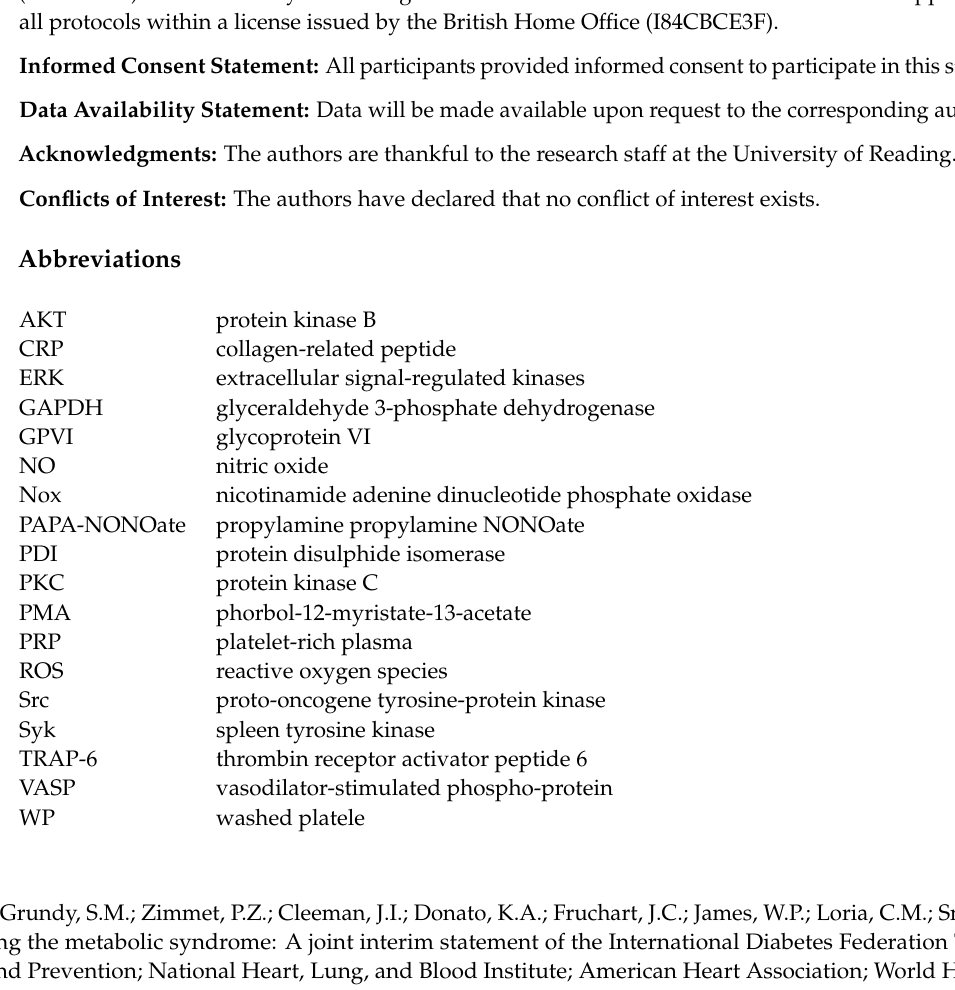
Figure S5: PDI and Nox-1 co-inhibition decreases phosphorylation of p47phox, Figure S6: Summary of molecular processes regulated by PDI and Nox-1 in collagen-mediated signal, Figure S7: Platelet PDI and Nox-1 are not increased in hyperglycaemia, Table S1: Full blood count of WT and Nox-1 − / − mice, Table S2: Summary statistics of study population (n = 137) and Supplementary